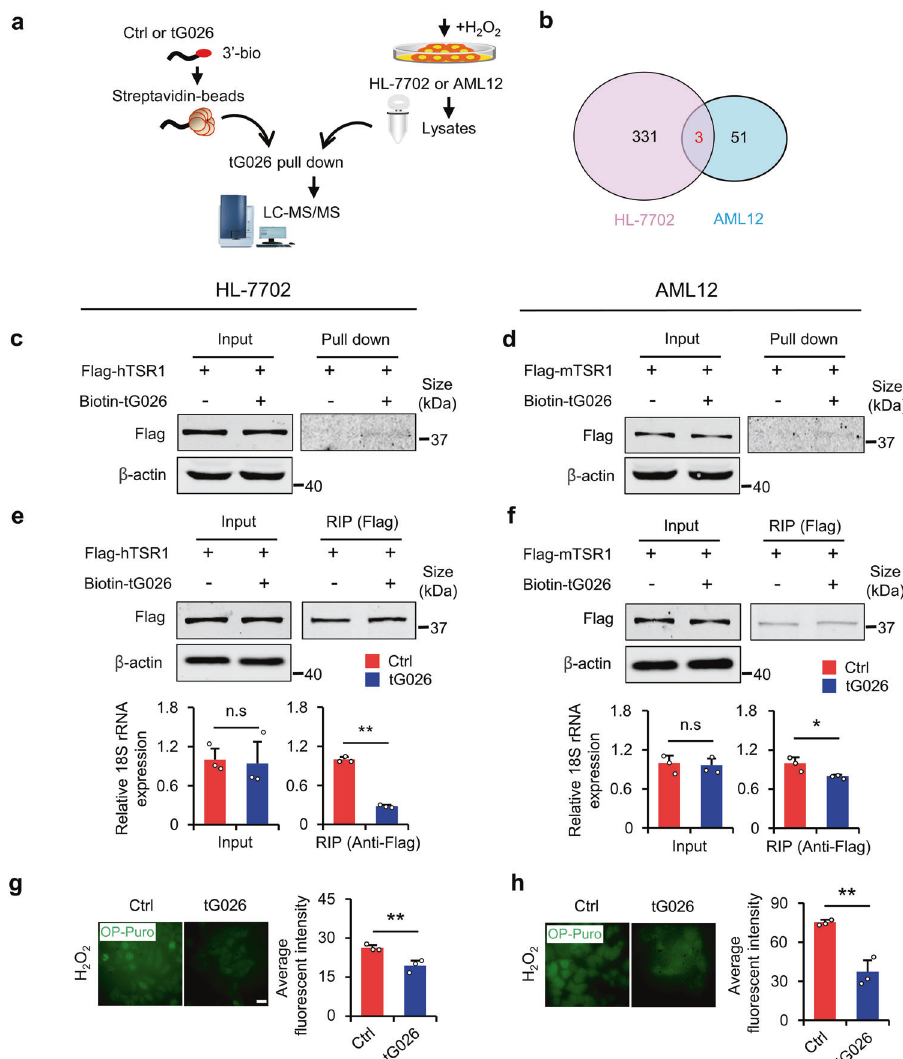
after tG026 RNA pull-down. The screening standards of interacting proteins are as follows: 1. The average value in control group must be zero; 2. The average value in tG026 group is non-zero. The red font represents the number of interacting proteins common to HL-7702 and AML12. n = 3 replicates. c , d RNA pull-down veri fi ed the interaction between TSR1 and tG026 in HL-7702 ( c ) and AML12 ( d ). e , f After tG026 and Flag- TSR1 were transfected, the interaction between TSR1 and 18S rRNA in HL-7702 ( e ) and AML12 ( f ) were detected by RIP. Input showing the unchanged 18S rRNA expression after transfection of tG026. n = 3 replicates. g , h Global protein synthesis under H 2 O 2 stress in HL-7702 ( g ) and AML12 ( h ) was assayed by OP-Puro incorporation. Representative images (left panel) and statistical results (right panel) are shown. Scale bar, 50 μ m. n = 3 replicates. All data are expressed as the mean ± SD. * P < 0.05, ** P < 0.01, n.s . no signi fi cance, Student ’ s t